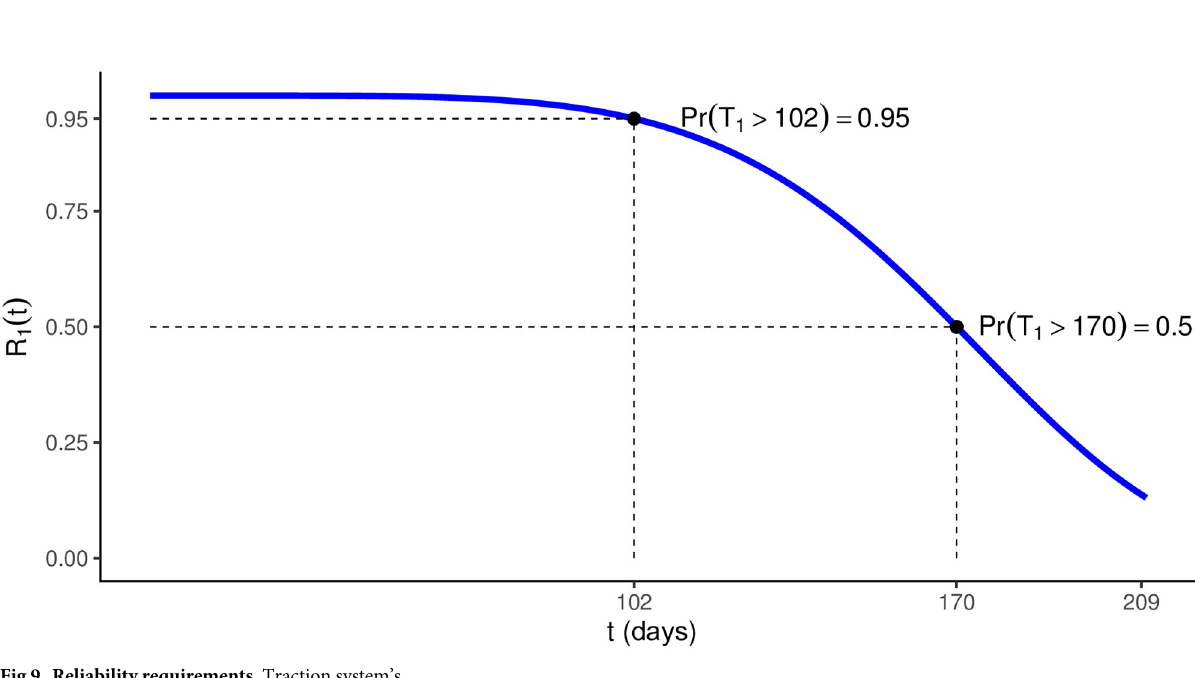
Fig 8. Estimated functions for the in-pipe robotic unit’s pressure vessel set system. First-failure time reliability (in black) and intensity (in red) functions by components, subsystems and systems.